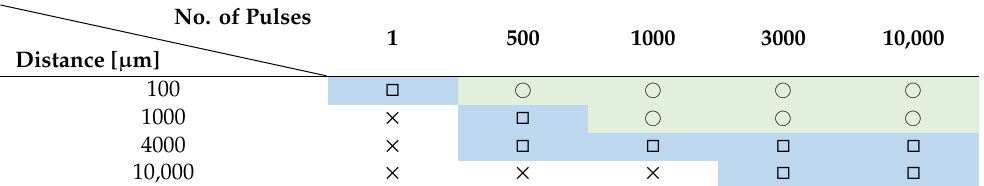
Table 1. E ff ect of the CYTOP–glass distance and the number of pulses on the glass